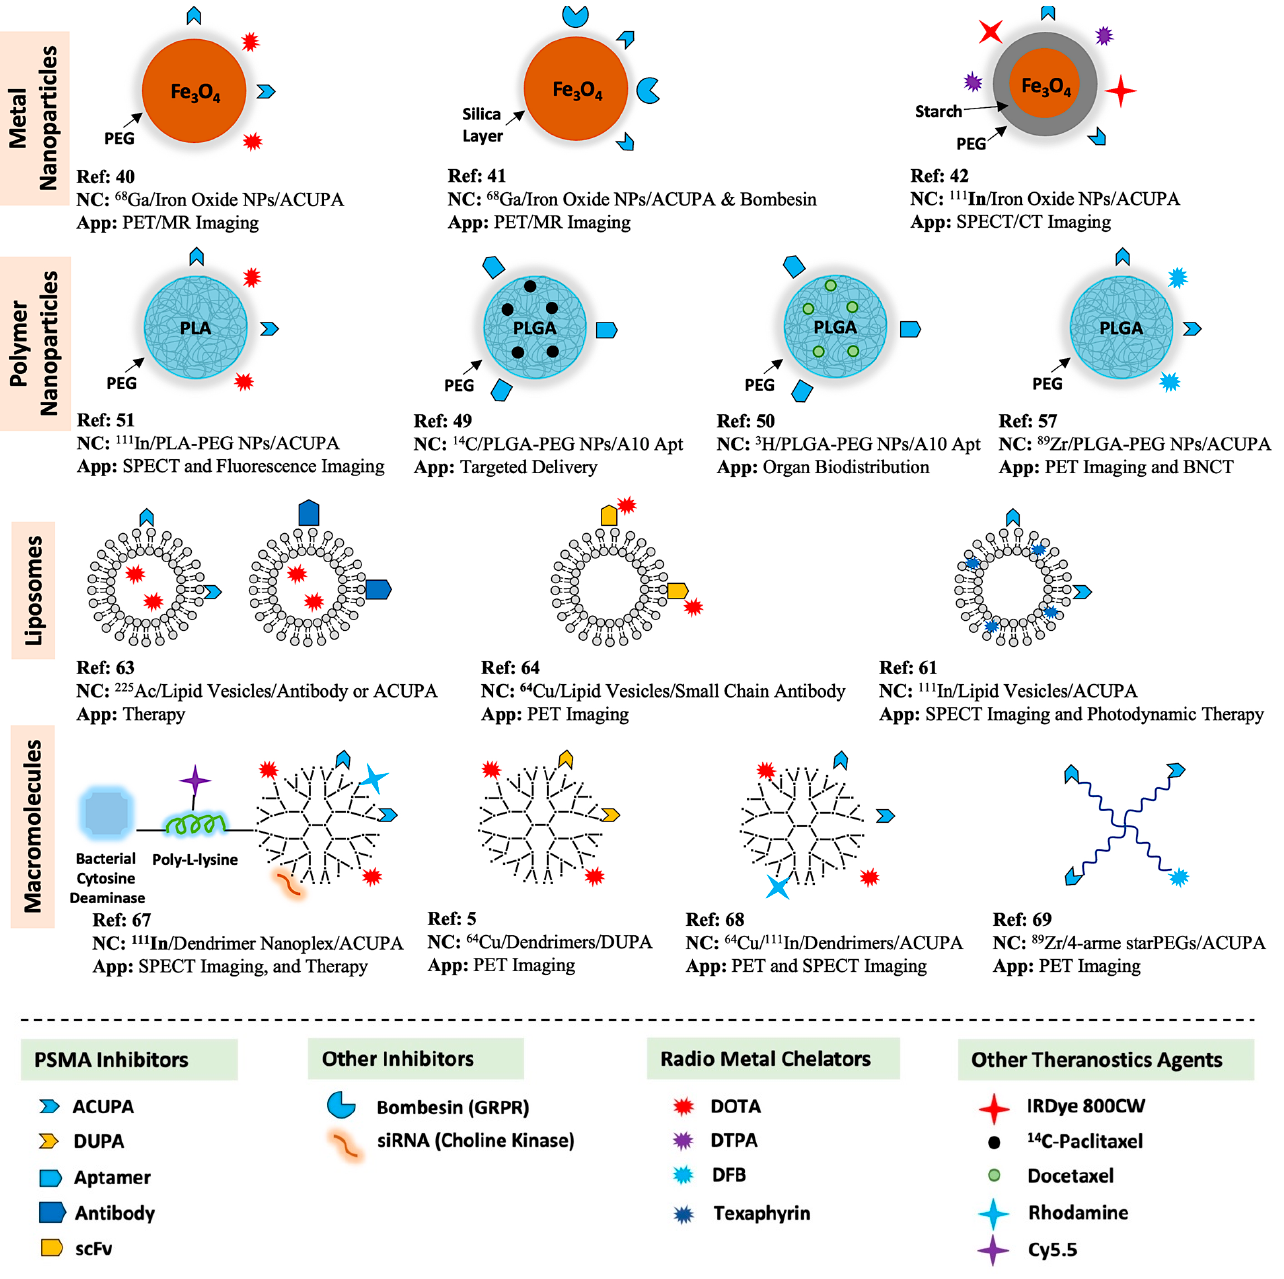
Figure 1. Summary of PSMA-targeted nanocarriers for radioligand imaging and treatment of PCa.